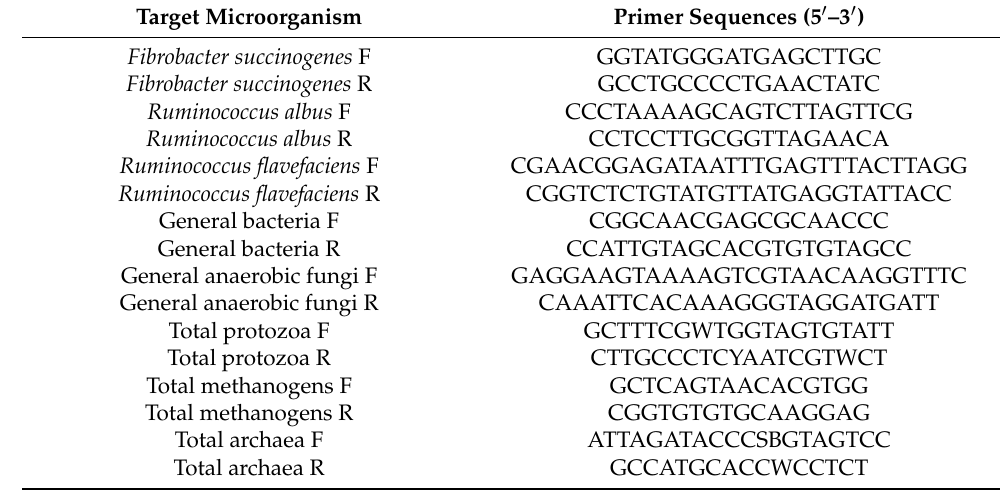
Table 2. Microorganisms and characteristics of the primers used in this study [24,27]. Target